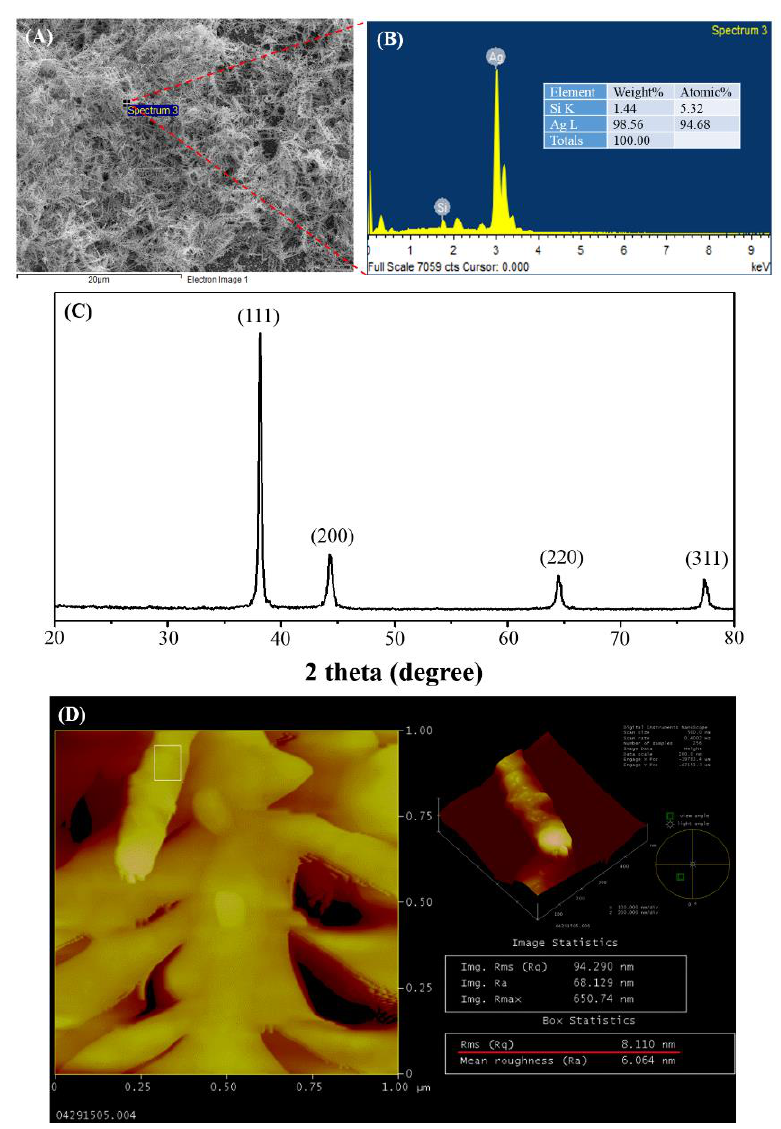
Figure 2. ( A ) SEM image, ( B ) EDS spectrum, ( C ) XRD spectrum, and ( D ) AFM image of the dendritic forest-like Ag nanostructures on a Si wafer.